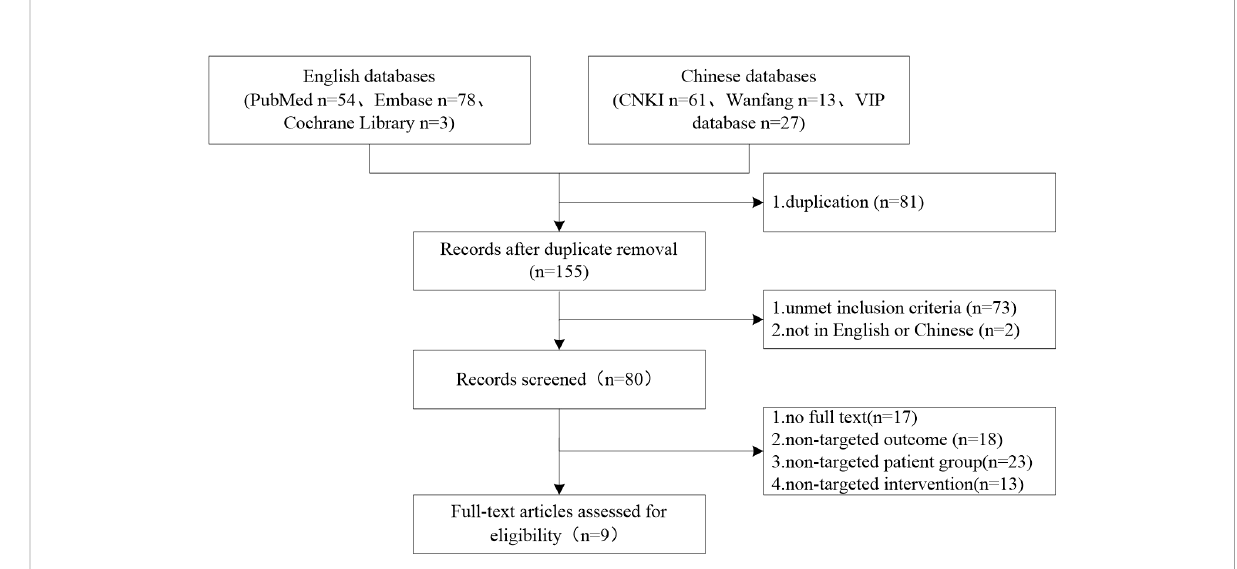
FIGURE 1 Flowchart of the literature search for ICI therapy in LC patients with COPD.